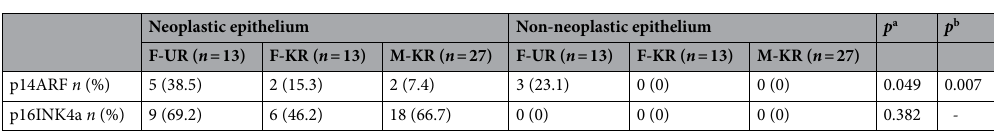
Table 4. Expression levels of p14ARF and p16INK4a in neoplastic and non-neoplastic epithelium. Values are expressed as the number (%). Comparisons among the three groups of neoplastic a or non-neoplastic epithelium b were performed using the χ 2 test. Statistical calculations were performed using JMP 14.3.0 F-UR female unknown-risk; F-KR female known-risk; M-KR male known-risk; p16INNK4 p16 inhibitor of cyclin- dependent kinase 4A; p14ARF p14 alternate reading